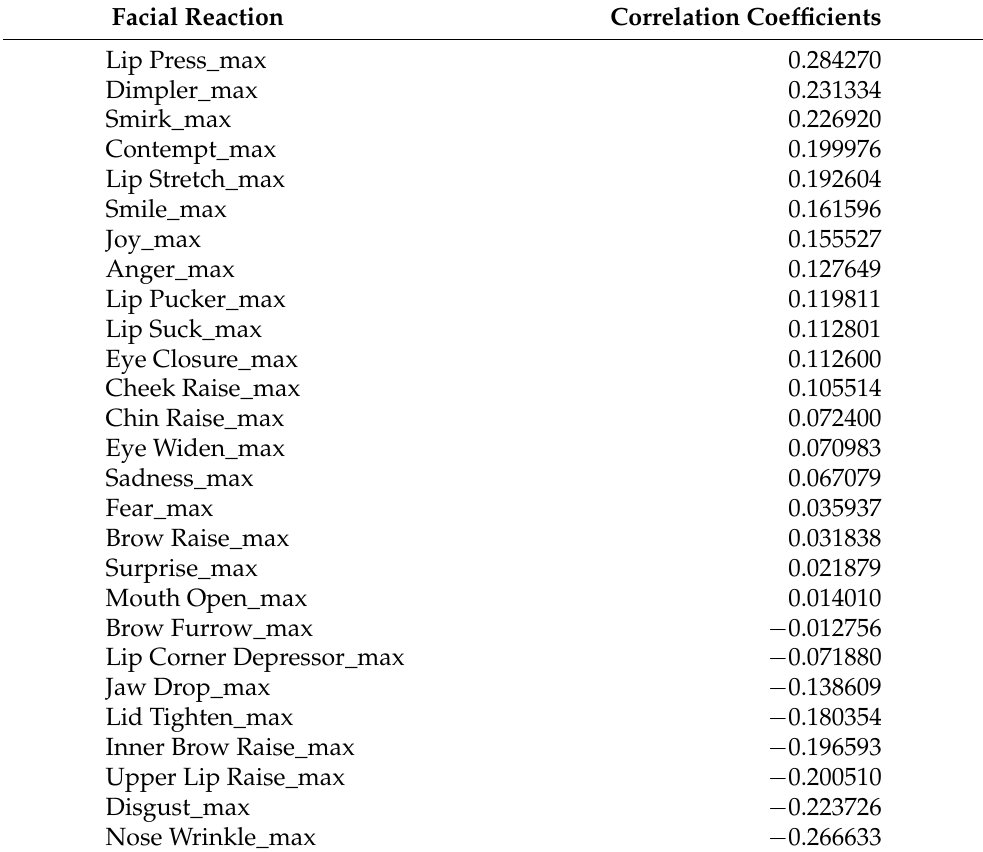
Table 1. Correlation coefficients between EQ score and facial reactions (sorted in descending order). Facial Reaction Correlation